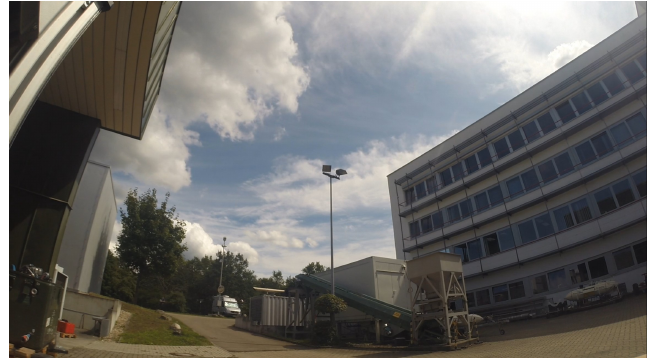
Figure 13. Example of drone detection